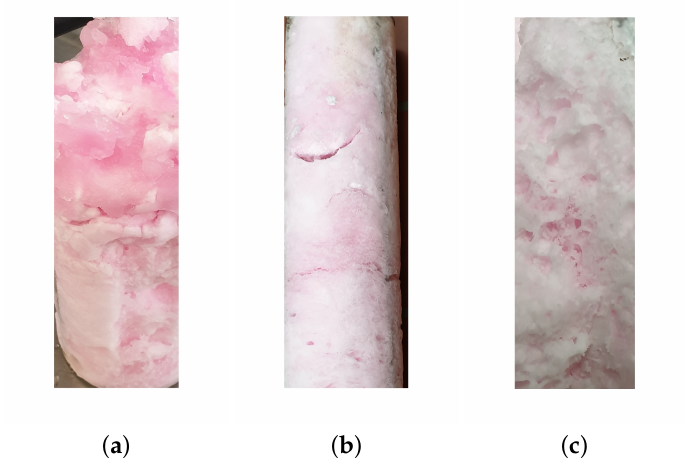
Figure 3. CO 2 hydrate formed in the water-sucrose-betanin model solution at different temperature and pressure conditions using a bubble column reactor: ( a ) hydrate block with hydrate slurry formed at 40 bar and 1 °C, ( b ) solid hydrate block formed at 37.5 bar and 3 °C, and ( c ) porous hydrate structure formed at 37.5 bar and 3